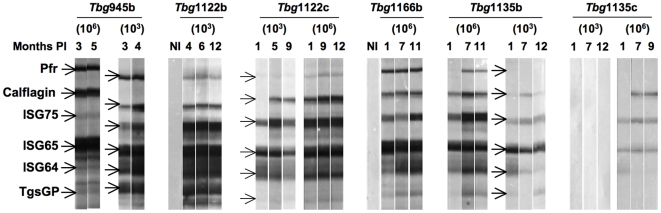
Reactivity patterns of immunoreactive invariant trypanosome proteins during BALB/c mice infections.Four mice were infected with either a low (103) or a high (106) load of Tbg945b, Tbg1122b, Tbg1166b, Tbg1135b or Tbg1135c isolates and their sera collected at different time points were tested by Western blotting (1/100 dilution) against a strip loaded with recombinant protein: 0.5 µg PFR and ISG75, 1 µg ISG65, ISG64 and TgsGP and 2 µg calflagin. The data are representative of one immunoblot out of 4 mice tested. NI represents the control sera before infection.